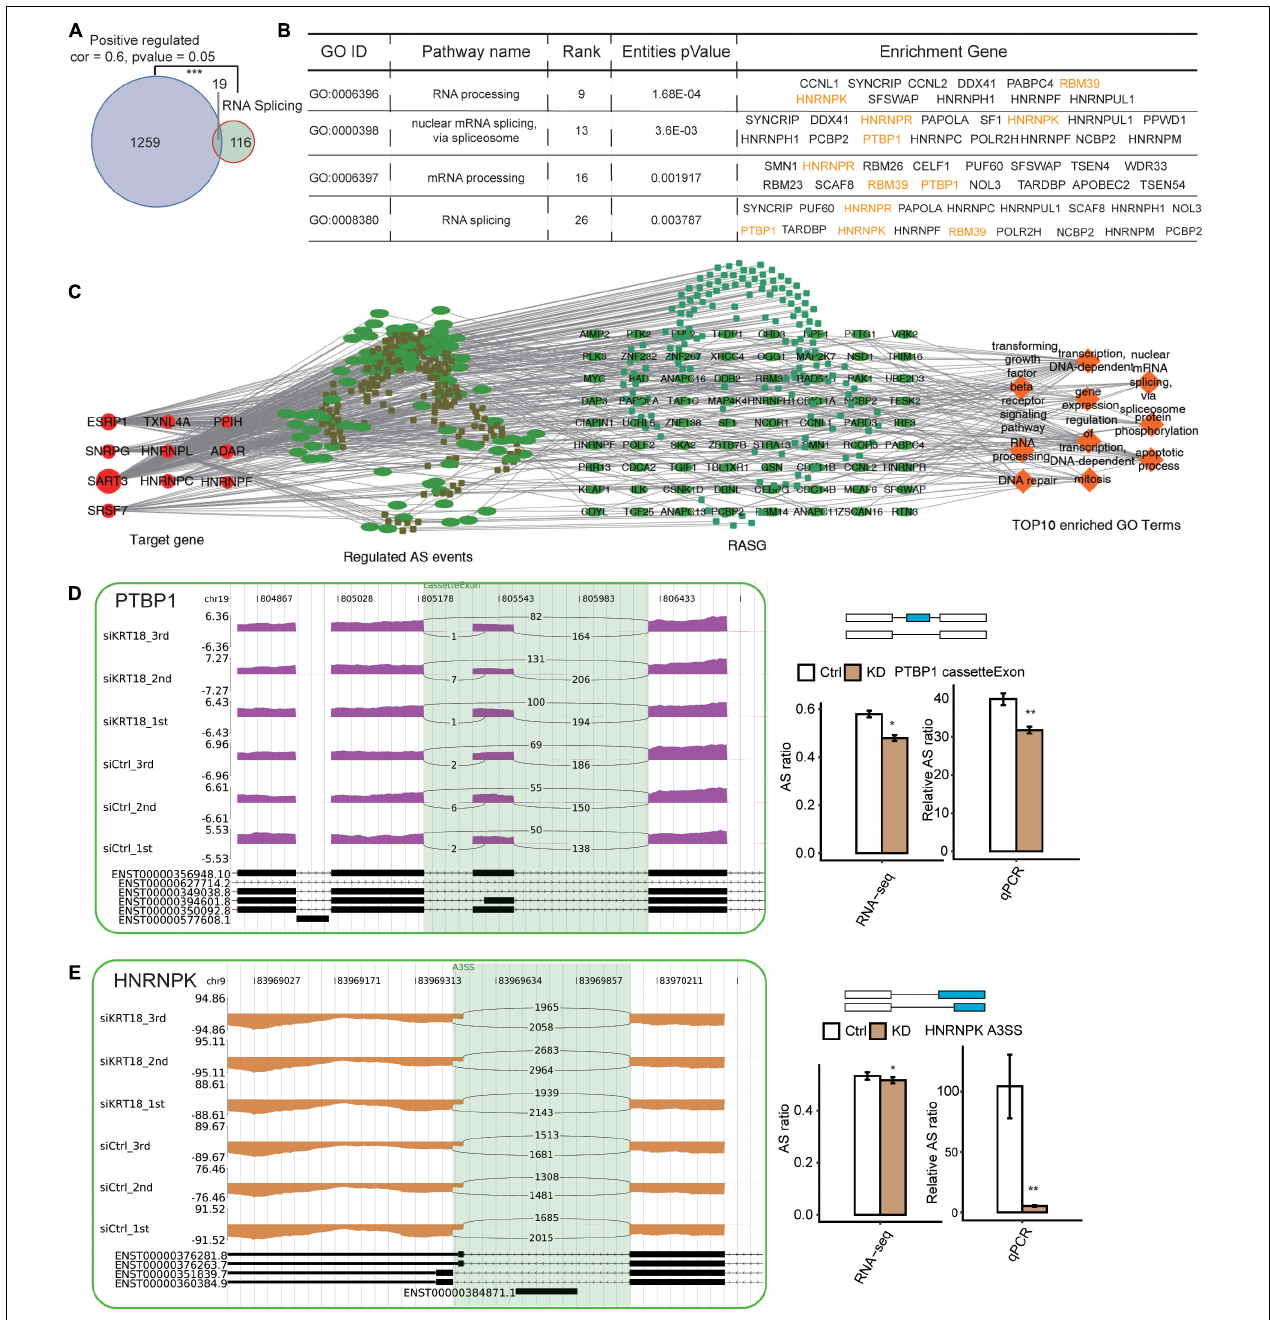
FIGURE 5 | Deregulation of splicing factors by KRT18 in GC samples and AGS cells. (A) Venn diagram shows the overlapping between KRT18-coexpressed genes positively and genes in RNA splicing–related terms from GO database. *** p < 0.001, hypergeometric test. (B) RNA splicing–related terms in GO biological process analysis of the RASGs from RNA-seq data in AGS cells. Validated RASGs using RT-qPCR in AGS cells were labeled in yellow. (C) The coderegulation of alternative splicing network between top10 hub RBPs (the leftmost part and the size of the circle represented the number of connections) and RASEs (the middle left part, which includes only NIR RASEs). The top enriched GO biological process of codisturbed RASGs (the middle right part) was shown in orange (the rightmost part). (D,E) Validation of two RASEs, cassette exon in PTBP1 (C) , and A3SS in HNRNPK (D) , by RT-qPCR in AGS cells. IGV sashimi plots show ASE changes occurred in KRT18 -KD cells and control (left panel), and the transcripts for the gene are shown below (right panel, top). The schematic diagrams (right panel, top) depict the structures of ASEs, AS (altered splicing events), and M (model splicing events) (alternative exon was labeled in blue). The exon sequences are denoted by boxes and intron sequences by the horizontal line. RNA-seq quantification and RT-qPCR validation of ASEs are shown in the bottom of right panel. The altered ratios of AS events in RNA-seq were calculated using the following formula: AS junction reads/(AS junction reads + M junction reads), whereas the altered ratios of AS events in RT-qPCR were calculated using the formula: AS transcripts level/M transcripts level. Error bars represent mean ± SEM. * p < 0.05, ** p < 0.01, Student t -test.